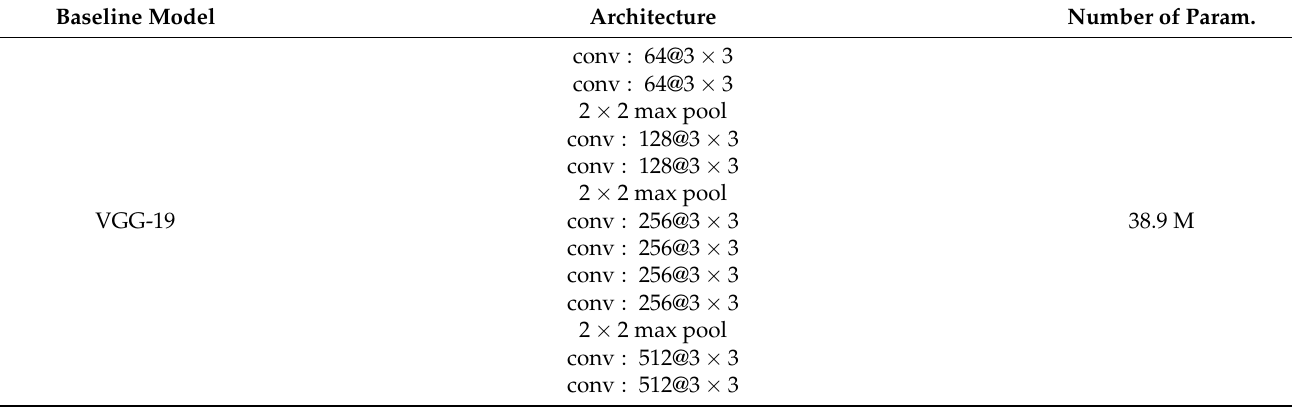
Table A1. Architectures of the VGG-19, ResNet-50, SE-ResNet-50, and DenseNet-121 models. Baseline